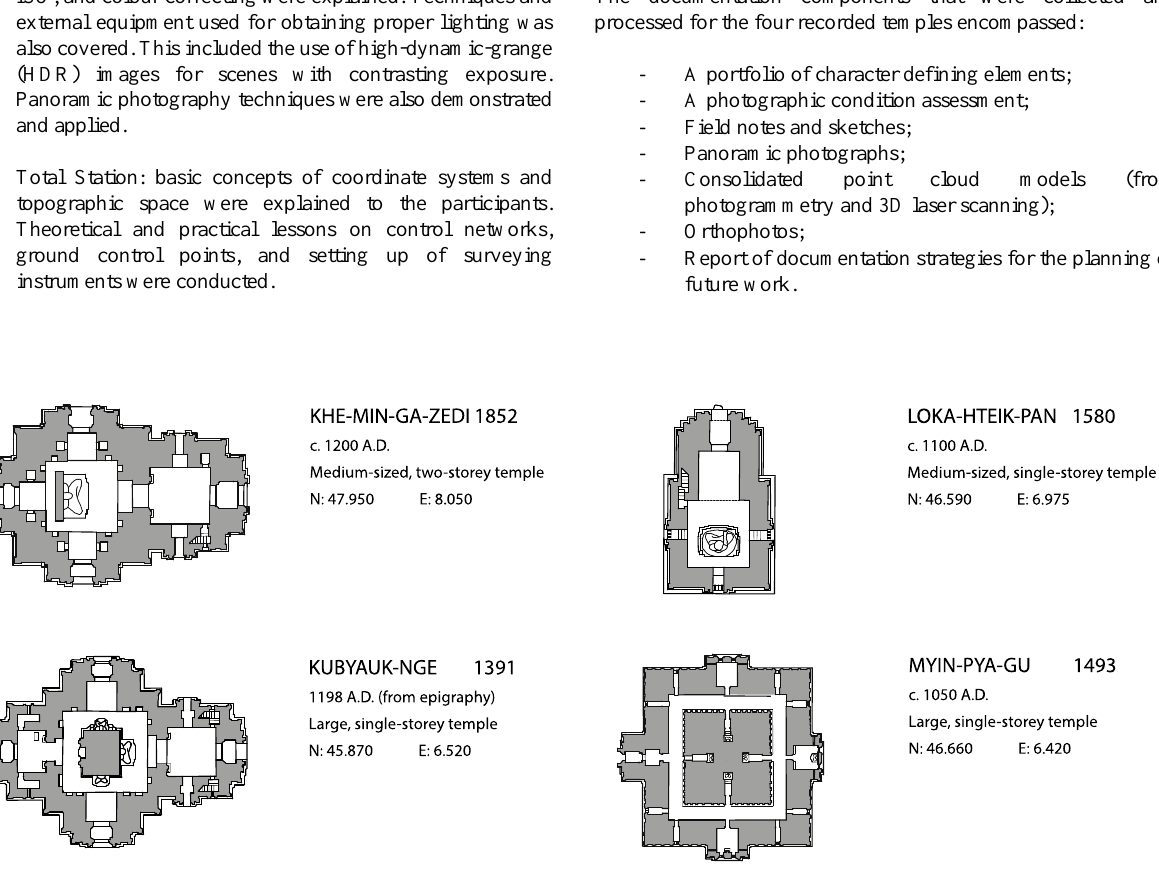
Figure 5. Infographic of the temples documented during the workshop, (Pichard, 1992), adapted by the